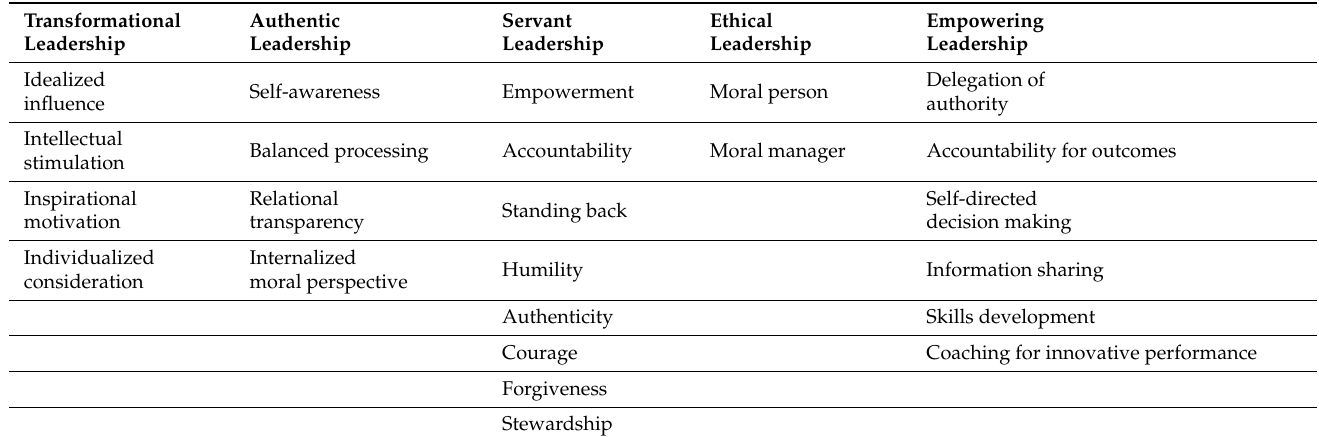
Table 1. Positive leadership styles and their